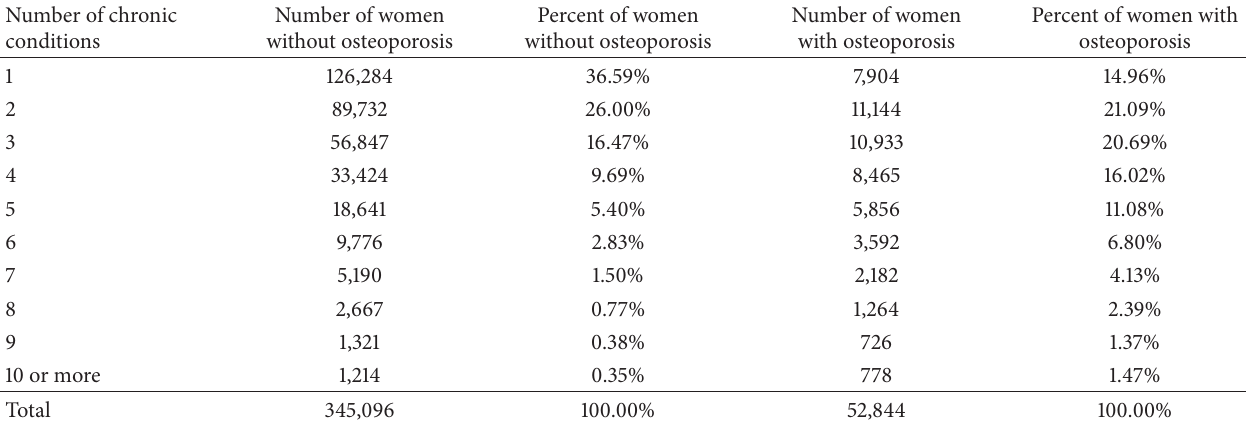
Table 2: Distribution of women with osteoporosis and without osteoporosis by the number of comorbidities.